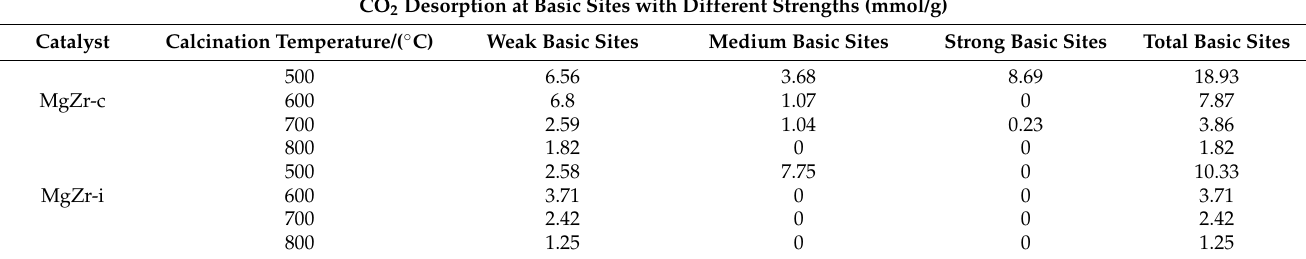
Table 4. Base properties of MgO/ZrO 2 catalysts.